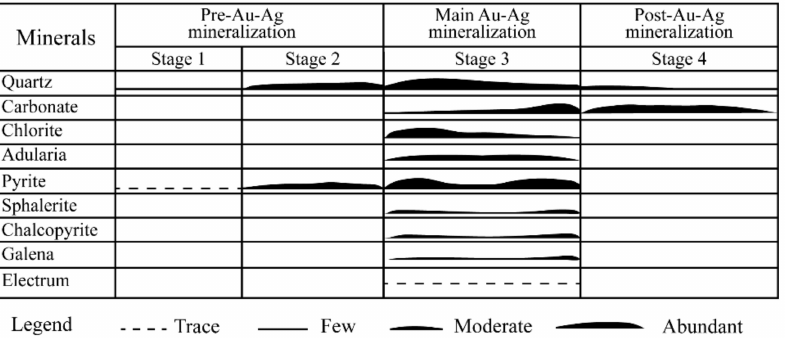
Figure 4. Paragenesis diagram of mineralization at the H ore lens showing the occurrences and relative abundance of minerals in each mineralization